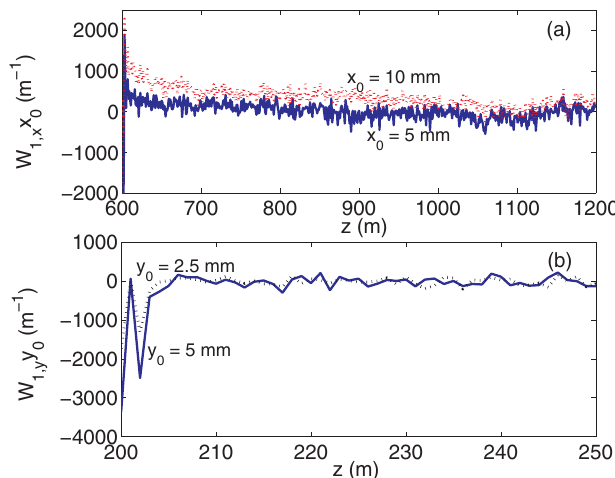
FIG. 13. (Color) Wake force due to electron cloud in a strong bending magnetic field. Plots (a) and (b) depict the horizontal and vertical wake forces for the displacement of 2.5, 5, and 10 mm. Primary electrons are produced uniformly on the cham- ber surface, and secondary ones are produced with a rate of (cid:1) 1 : 5 and a reflection of (cid:3) (cid:1) 0 : 5 (cid:3) 2 ; max 0